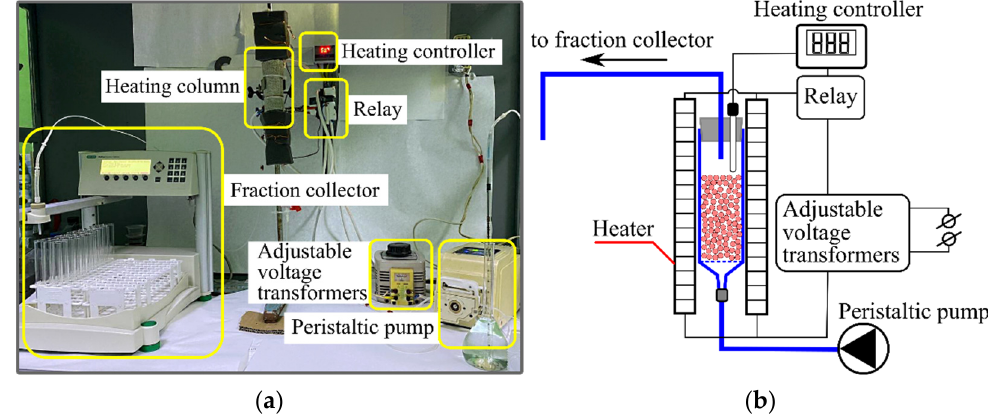
Figure 2 . The column for studying the effect of the temperature of the H 2 SO 4 solution on the efficiency of dissolution of iron oxide deposits: ( a ) the appearance of the device, ( b ) the conditional scheme of the device.